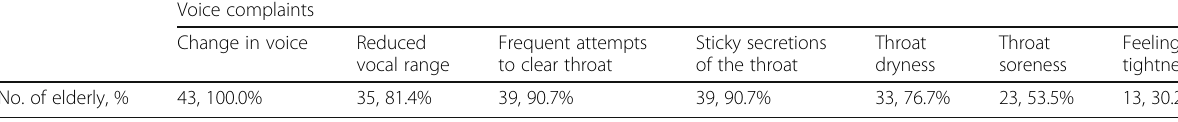
Table 2 Self-reported symptoms in the elderly group with voice complains Voice complaints Change in voice Reduced Frequent attempts Sticky secretions vocal range to clear throat of the throat